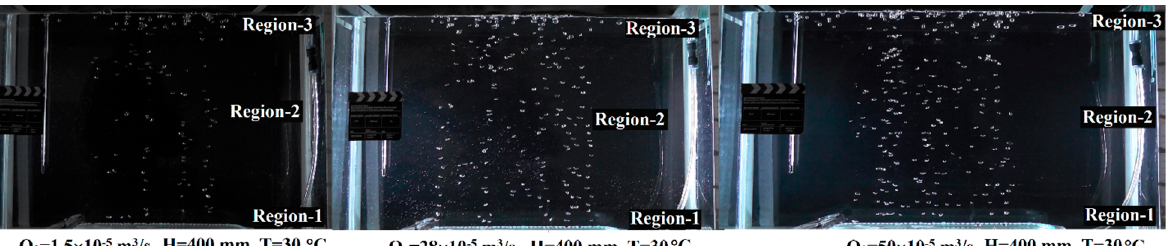
Figure 2. Typical images of bubbles.